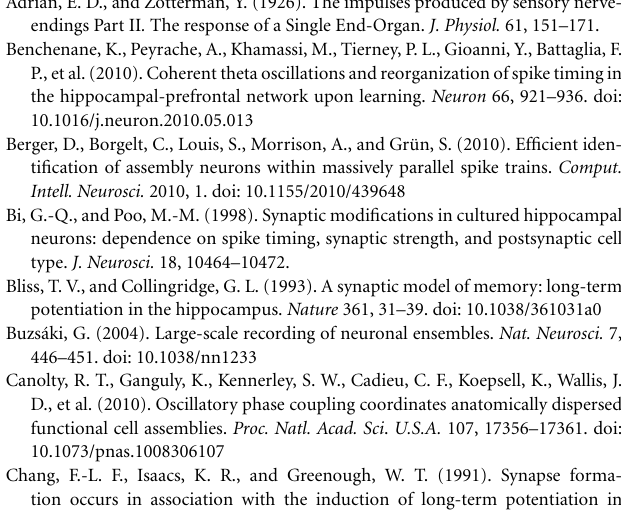
FIGURE 8 | Continued random graphs fromeachoftheexperimental periods compared usingaNaïve Bayes classifier;e.g., 20graphs fromPREWKcompared with20graphs from EXP WK.Insomecasesof theparameter screening, wecouldnotobtainthe minimum 20graphs necessary for theclassification.Forinstance, itwas impossibletogenerate onesinglegraphcomprising 200activations (200% of Number of Assemblies 2 for rat#3) withinthe10msmaximum IAI.These conditionswerecodedbluetoindicatenoclassification.ThemaximumAUROC valueof eachpanel isindicated. (A,B) Sortingofbehavioral states. (A) Panels show theclassificationqualityacrossdifferent maximumIAI